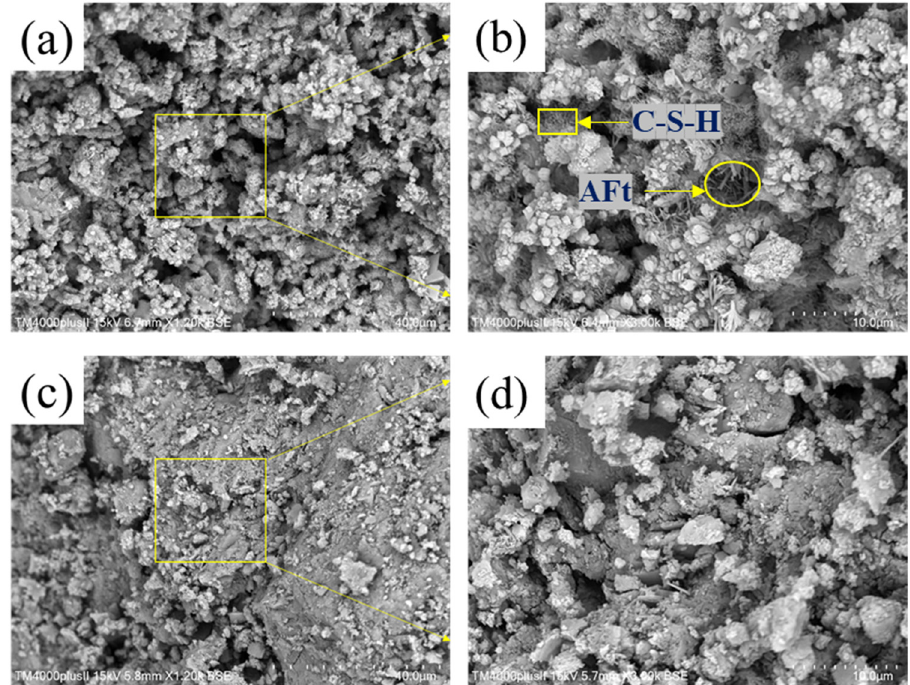
Figure 5: SEM images: ( a ) S - 0 ( 1 day ) ampli fi ed factor 1,200; ( b ) S - 0 ( 1 day ) ampli fi ed factor 3,000; ( c ) S - 0.5 ( 1 day ) ampli fi ed factor 1,200; and ( d ) S - 0.5 ( 1 day ) ampli fi ed factor